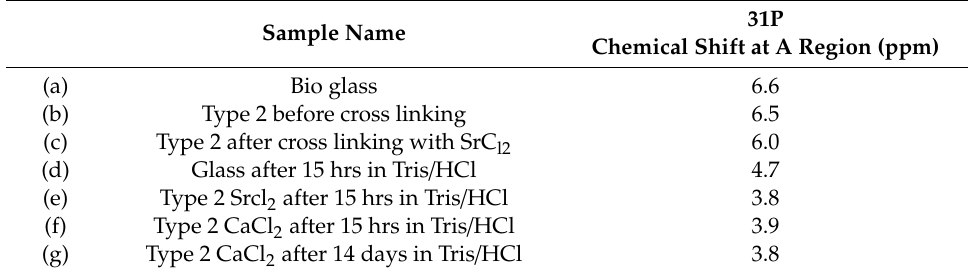
Table 5. Assignments of the resonances in the 31P MAS-NMR spectrum (ppm).